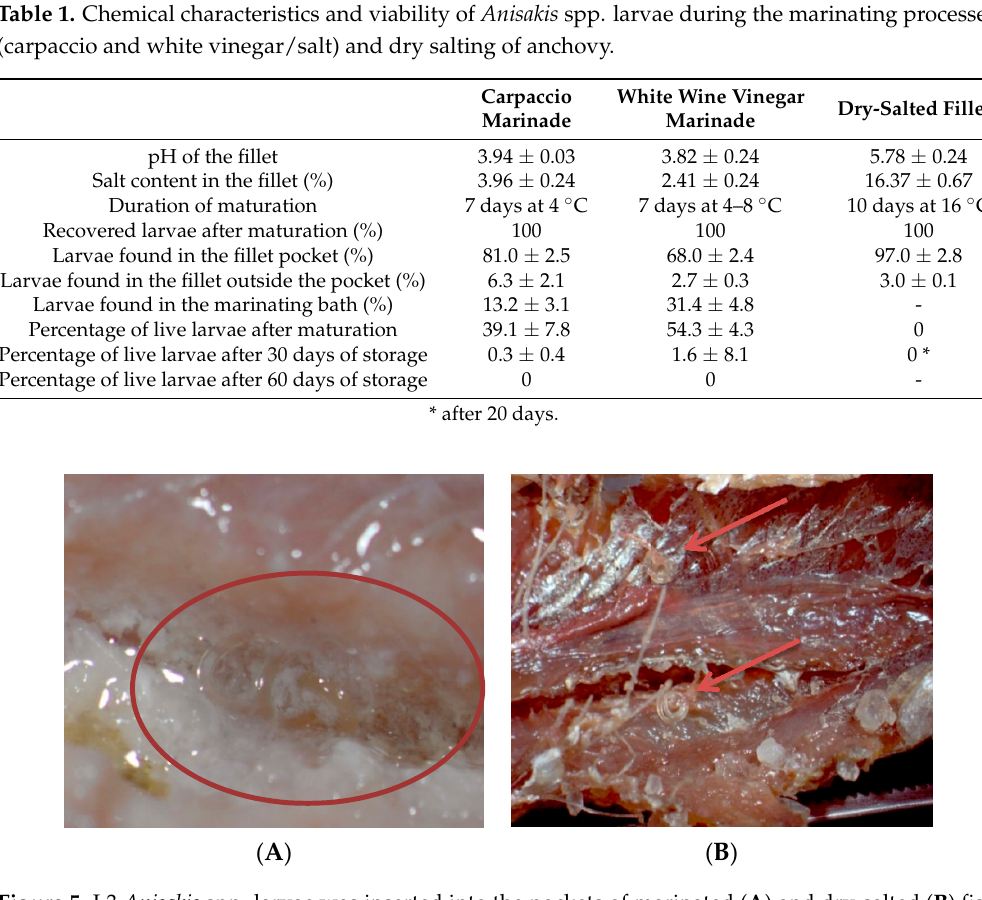
Figure 5. L3 Anisakis spp. larvae was inserted into the pockets of marinated ( A ) and dry-salted ( B ) fish during the maturation period of 7 and 10 days. Table 1. Chemical characteristics and viability of Anisakis spp. larvae during the marinating processes (carpaccio and white vinegar/salt) and dry salting of anchovy.